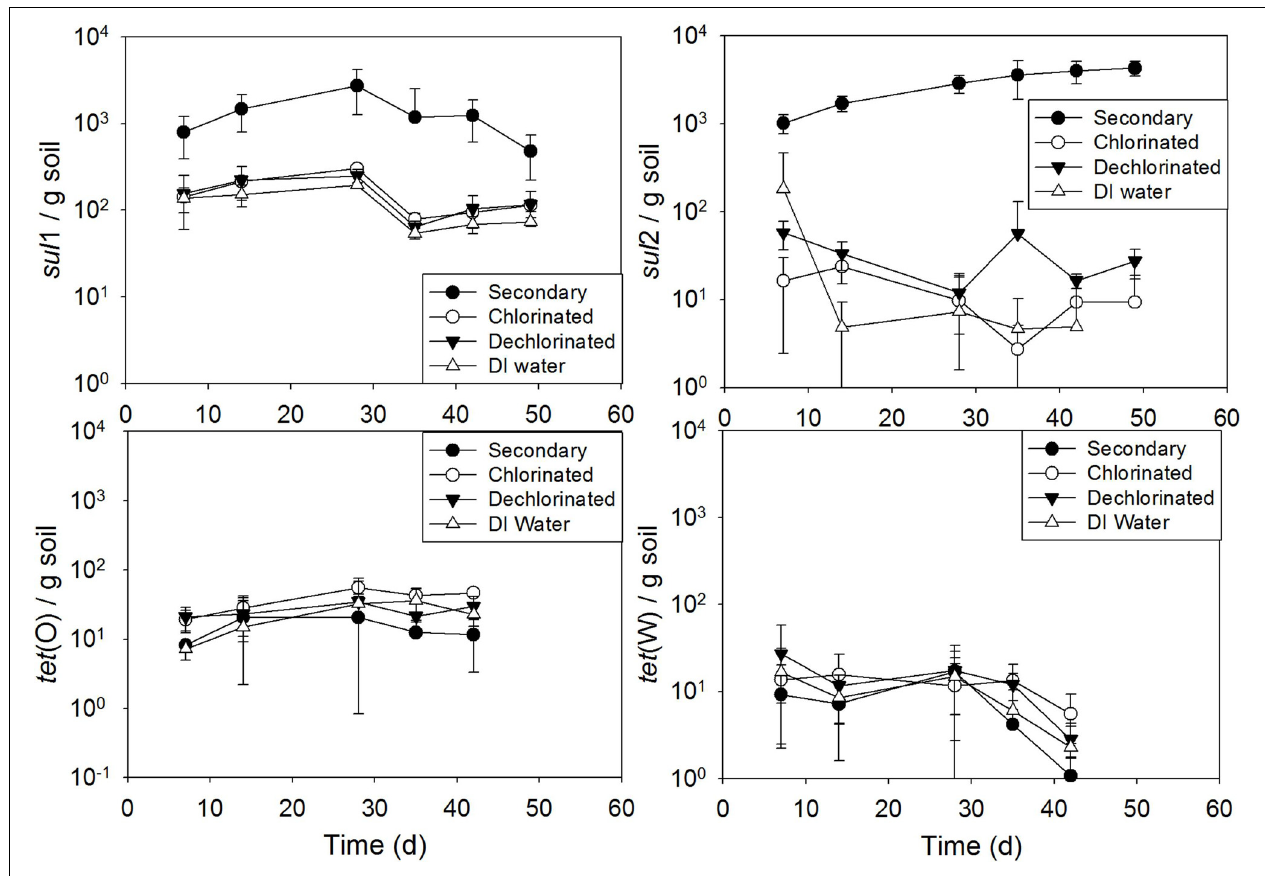
FIGURE 7 | sul 1, sul 2, tet (O) and tet (W) genes in soils periodically irrigated with secondary, chlorinated, dechlorinated domesticWWTP effluents and deionized (DI) water, normalized to soil mass (wet weight). Error bars represent standard deviation of triplicate